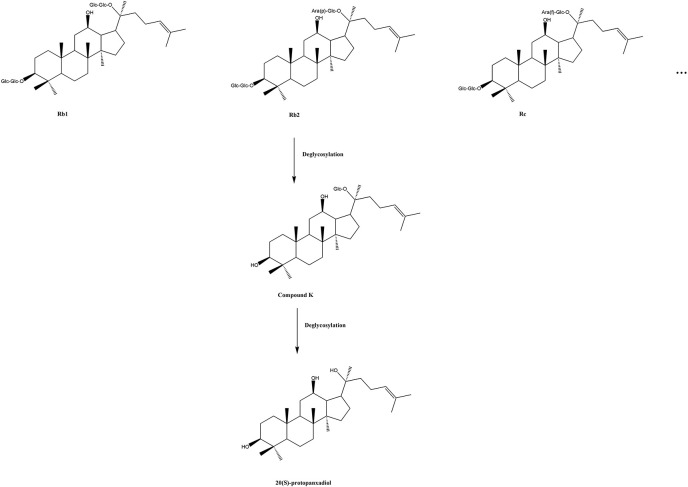
A sketch map of conversion of protopanaxadiol type ginsenosides. Glc, D-glucopyranosyl; Ara(p), L-arabinopyranosyl; Ara(f), D-arabinofuranosyl.